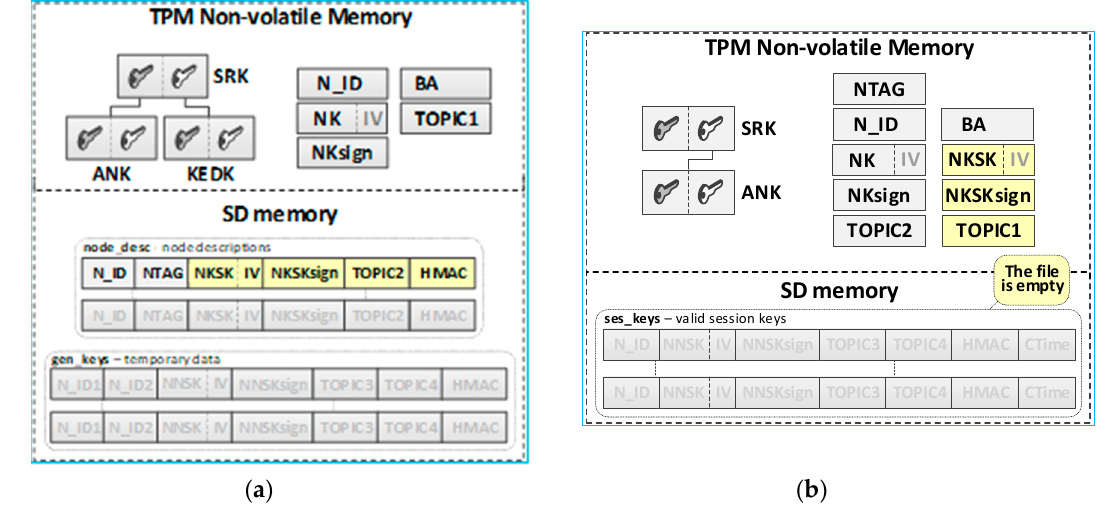
Figure 14. The sequence diagram for the N node initialization procedure ( a ) and the data stored on the KS node after the initialization procedure ( b ).